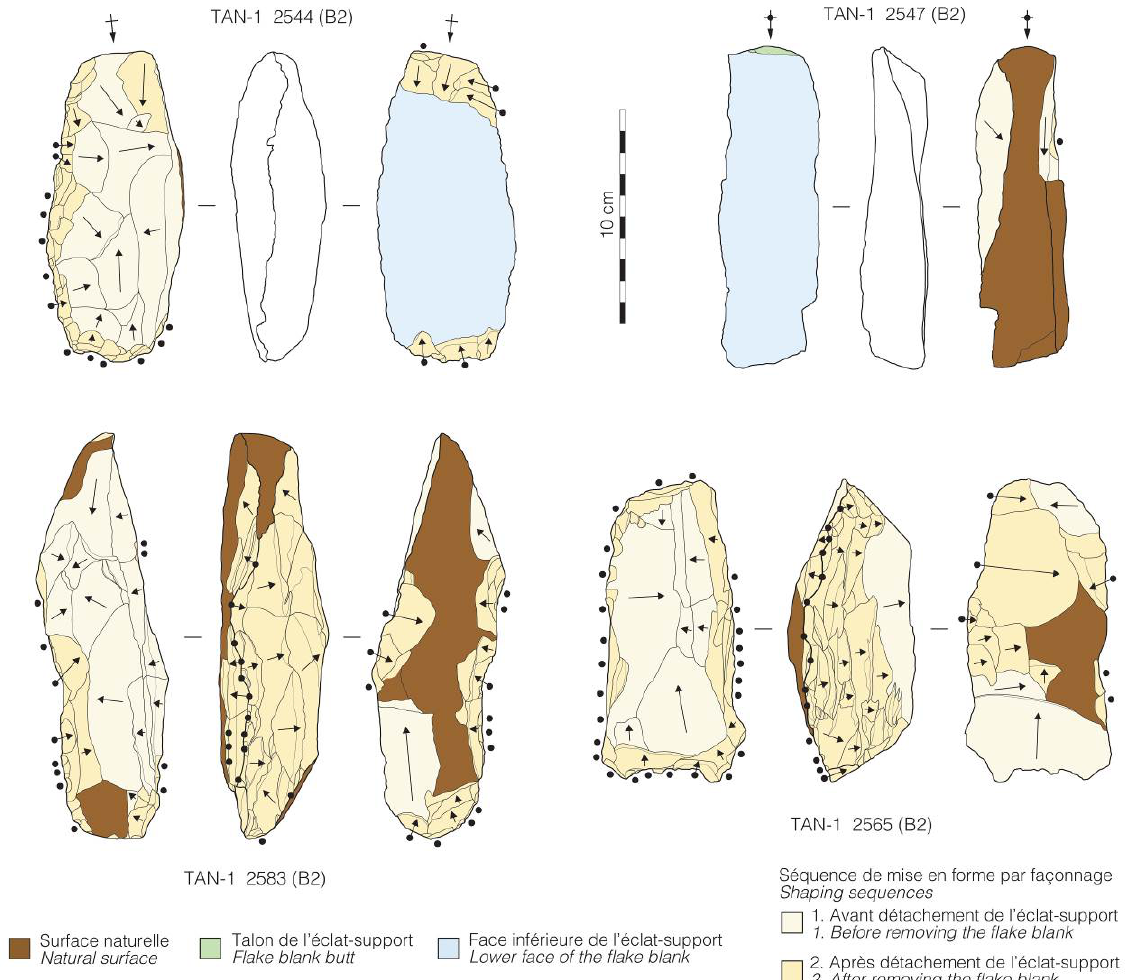
Figure 16. Schéma diacritique des ébauches issues de la zone d'extraction à Tanataetea. Figure 16. Diacritical sketch of Tanataetea quarry area